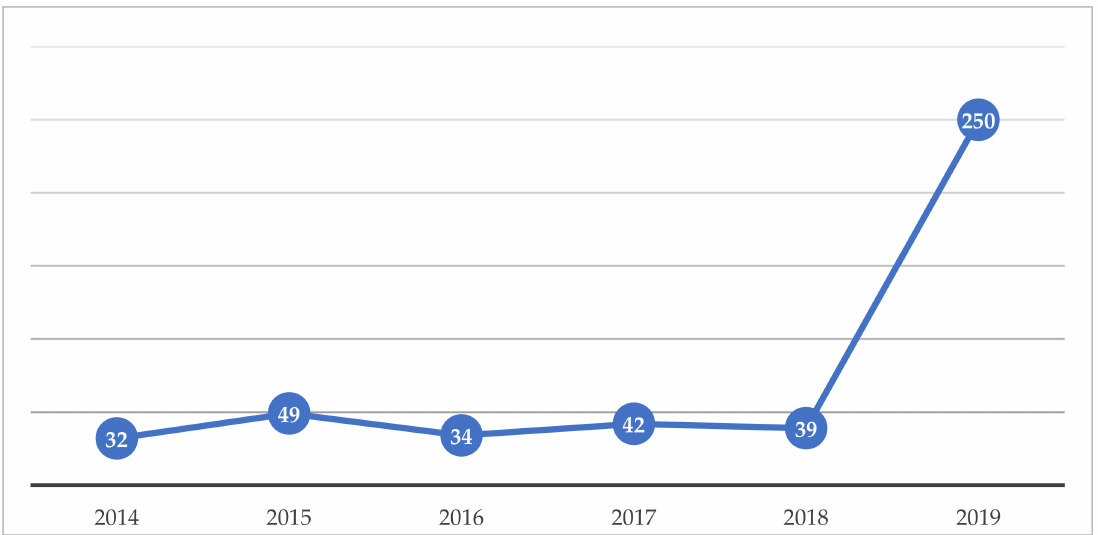
Figure 2. Number of publications per year.